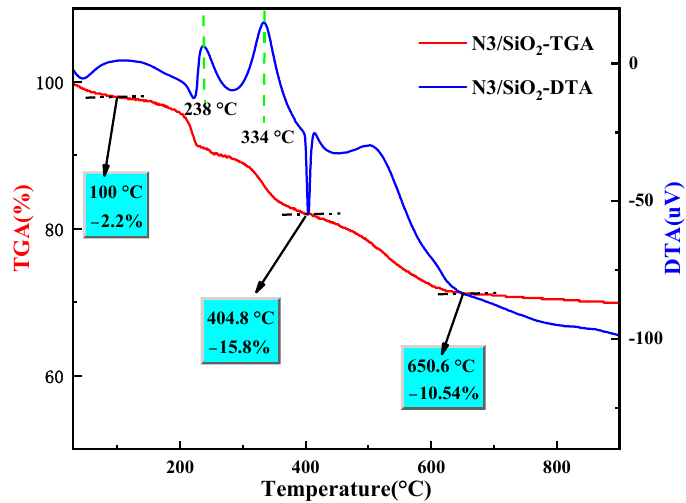
Figure 4. The TGA/DTA curves of the N3/SiO 2 .